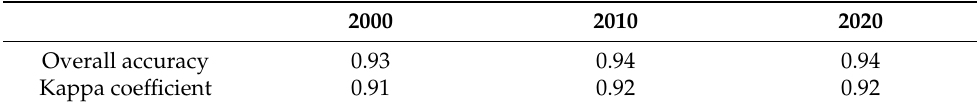
Table 1. The overall accuracy and kappa coefficient of classification results.